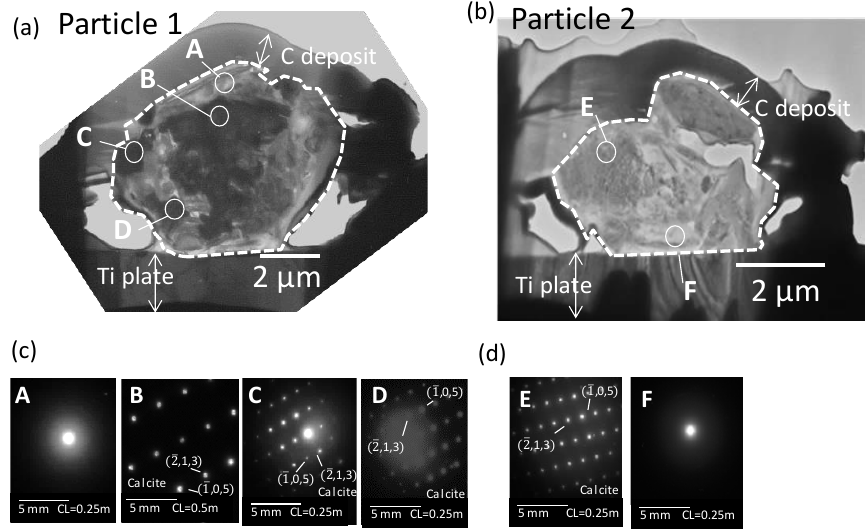
Figure 3. Transmission electron microphotograph of the cross-sections of Dust Particles 1 ( a ) and 2 ( b ) and SAED patterns for the spots A–D in the Dust particle 1 ( c ) and for the spots E and F in the Dust particle 2 ( d ). The particle part borders are presented as broken white lines. CL is the camera length.